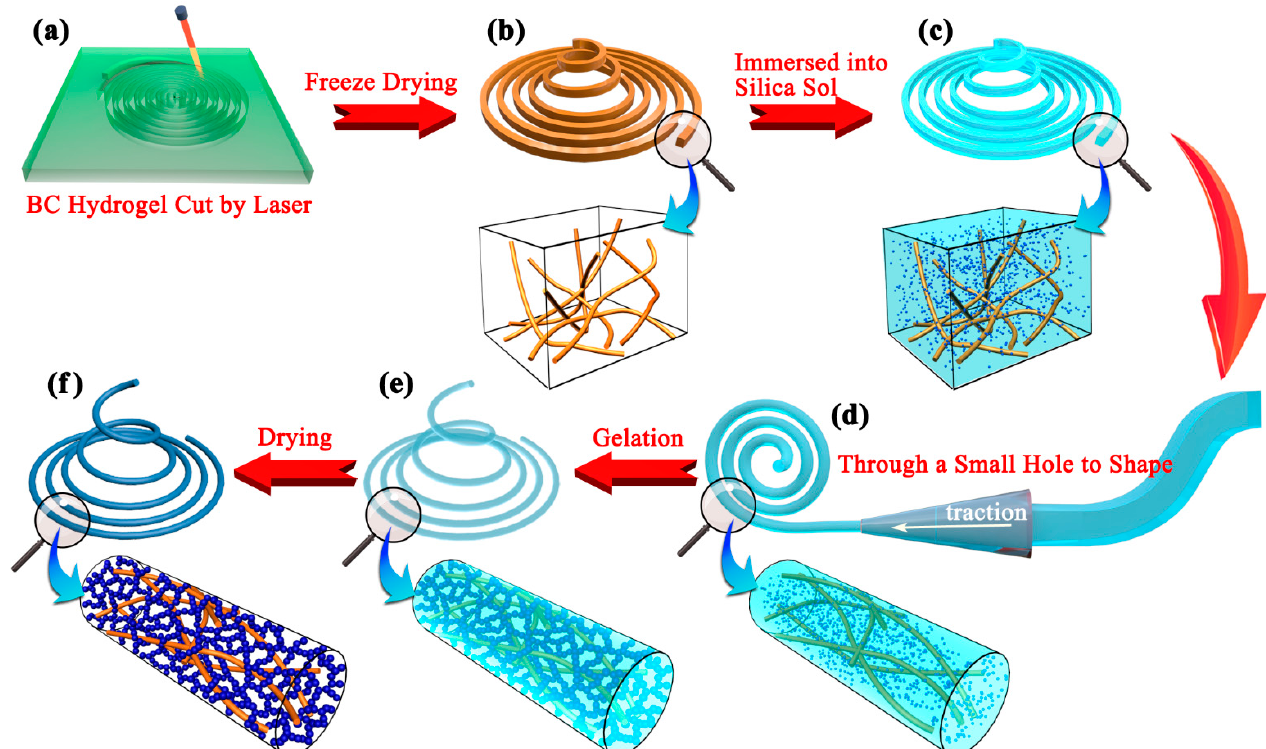
Figure 1. Schematic of the preparation process of CAFs. A nata-de-coco slice was cut by a laser ( a ), followed by freeze drying to obtain a fiber-like matrix consisting of BC nanofibers ( b ). The matrix containing silica sols ( c ) was reshaped by a small hole mold ( d ). After the silica gel skeleton was formed in the matrix ( e ), the fiber-like composite wet gel was dried at ambient pressure after hydrophobization to obtain CAFs ( f ).